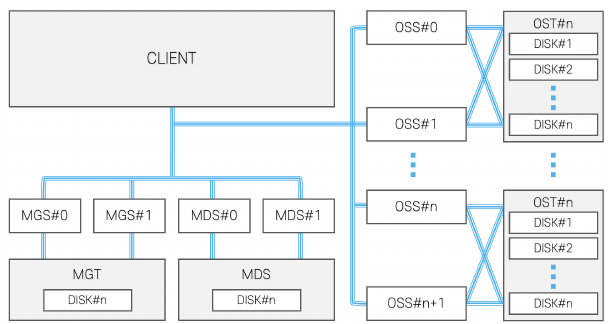
Figure 4. Structure of